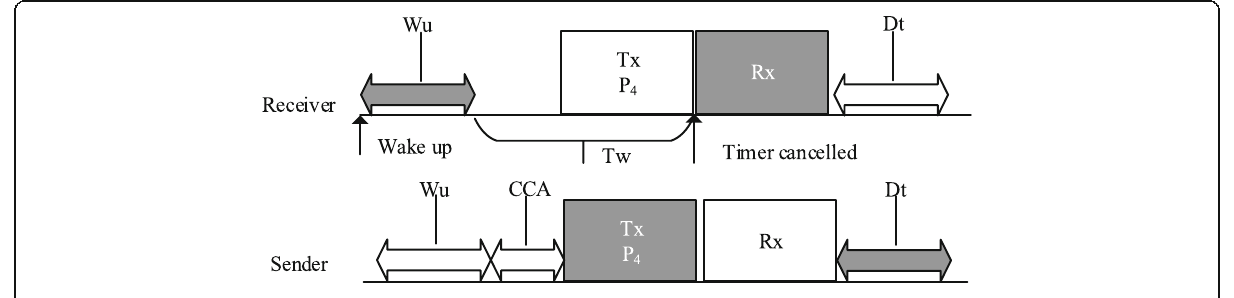
Fig. 5 Initial topology diagram of network 1